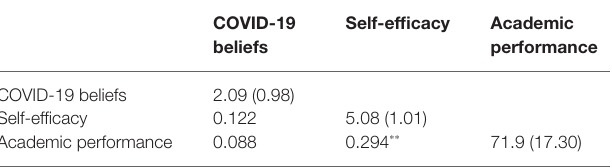
TABLE 1 | Correlation matrix, means (SDs) on the